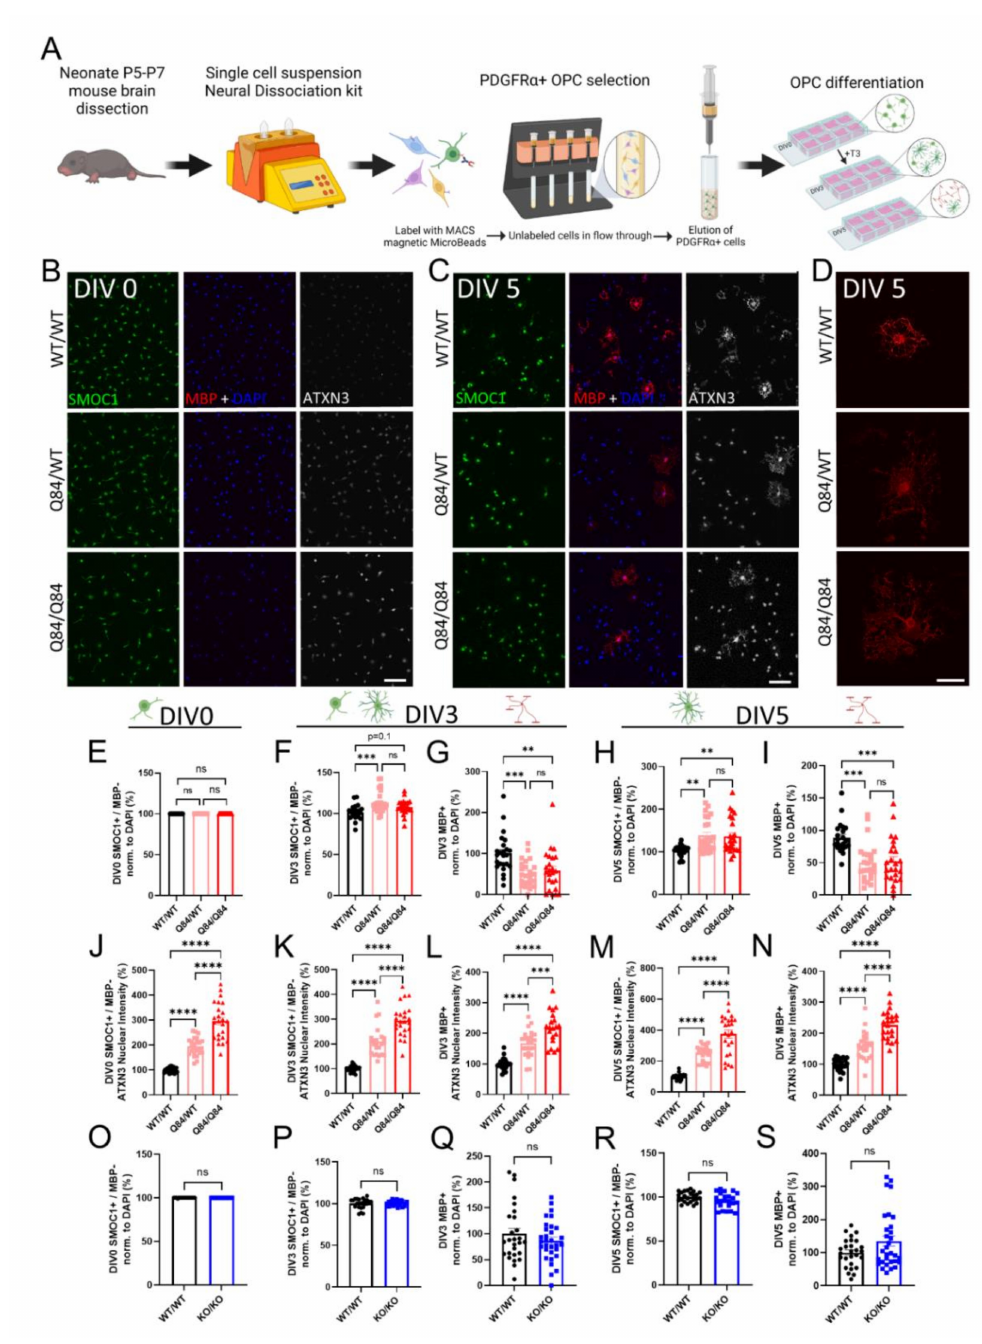
Figure 1. ATXN3 gain of toxic function, but not loss of function, leads to cell-autonomous oligo- dendrocyte maturation impairments. ( A ) Schematic of primary OPC isolation and culture. ( B , C ) Representative immunofluorescent images of SMOC1 (green), MBP (red), ATXN3 (white), and DAPI (blue) expression in cultured WT/WT, Q84/WT, and Q84/Q84 oligodendrocytes prior to differentiation (DIV0) ( B ) and after 5 days of differentiation (+T3, DIV5) ( C ). Scale bar, 100 µ m. ( D ) Representative high magnification images of MBP staining of cultured WT/WT, Q84/WT, and Q84/Q84 oligodendrocytes depict irregular branching in Q84 cells. Scale bar: 25 µ m. ( E , F , G ) Cell counts of immature oligodendrocytes (SMOC1+/MBP − ) at DIV0 ( E ), DIV3 ( F ), and DIV5 ( H ). ( G , I ) Cell counts of mature oligodendrocytes (MBP+) at DIV3 ( G ) and DIV5 ( I ). No differences in cell counts were found at DIV0, however, at DIV3 and DIV5, immature oligodendrocytes were increased and mature oligodendrocytes were significantly decreased in diseased mice. ( J ) Quantification of average ATXN3 nuclear intensity in Q84 OPCs at DIV0. ( K – N ) Quantification of average ATXN3 intensity